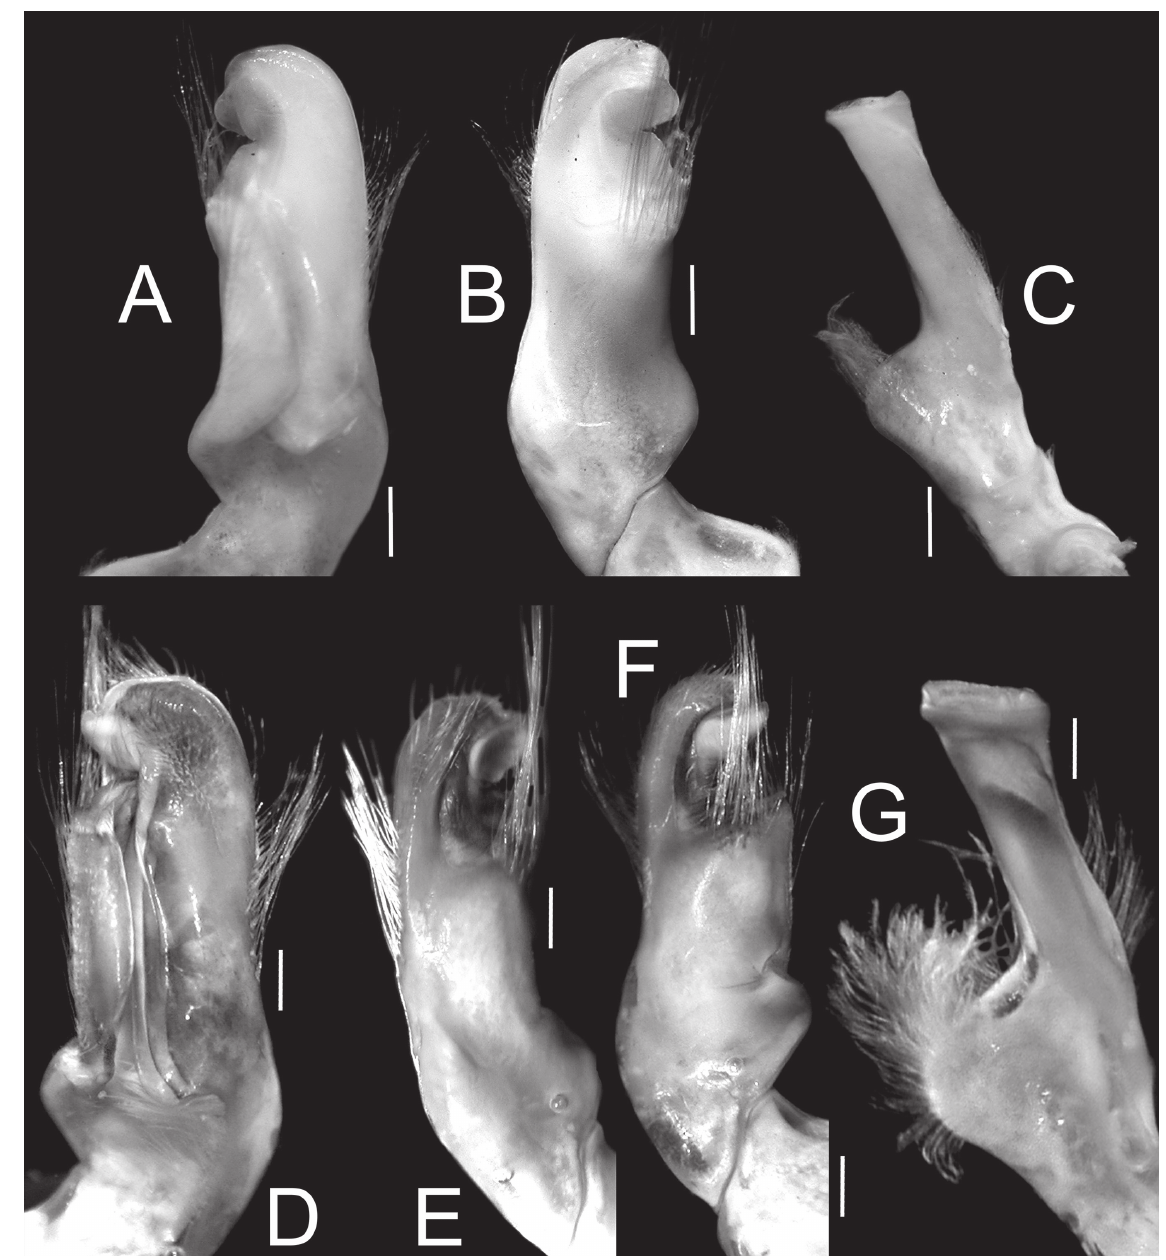
Fig. 15. Gonopods. A – C . Moloha grandperrini Guinot & Richer de Forges, 1995. Holotype, ♂ (cl 46.5 mm, cw 39.0 mm) (NHM 1948.9.7.27), Maldives. D – G . Moloha tumida sp. nov. Holotype, ♂ (cl 55.7 mm, cw 50.6 mm) (DABFUK), Kerala, India. — A , D . Ventral view of left G1. B , F . Dorsal view of left G1. E . Outer-lateral view of left G1. C , G . Left G2. Scale bars = 1